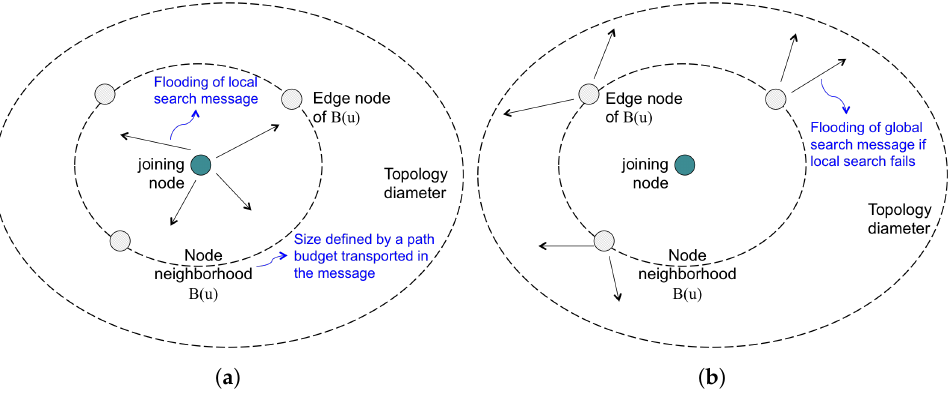
Figure 1. Two-stage search process: ( a ) Local search: joining node searching the MDT in its neigh- bourhood; ( b ) Global search: edge nodes searching outside the joining node’s